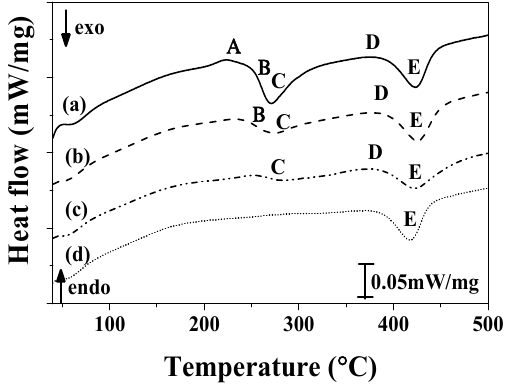
Figure 10. The heat flow curves of Al-3.5Mg 2 Si samples according to increase of aging treatment temperature: ( a ) 180 °C, ( b ) 200 °C, ( c ) 220 °C, and ( d ) 240 °C.